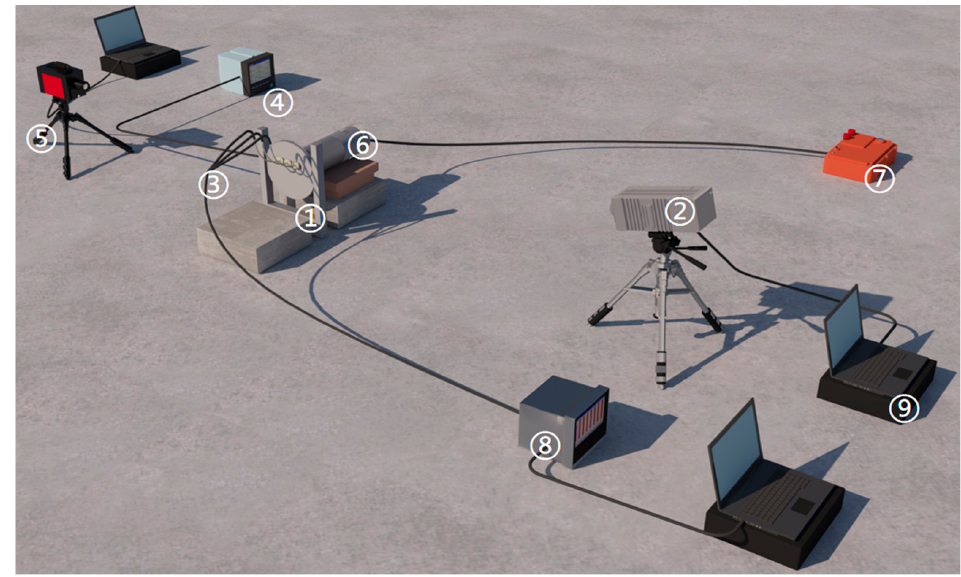
Figure 2. The layout of test equipment: (1) steel target, (2) high-speed camera, (3) thermocouple and thermal compensation wire, (4) internal electronic piezo gauge and recorder, (5) infrared camera, (6) eruption device, (7) trigger, (8) temperature recorder, (9) computer.